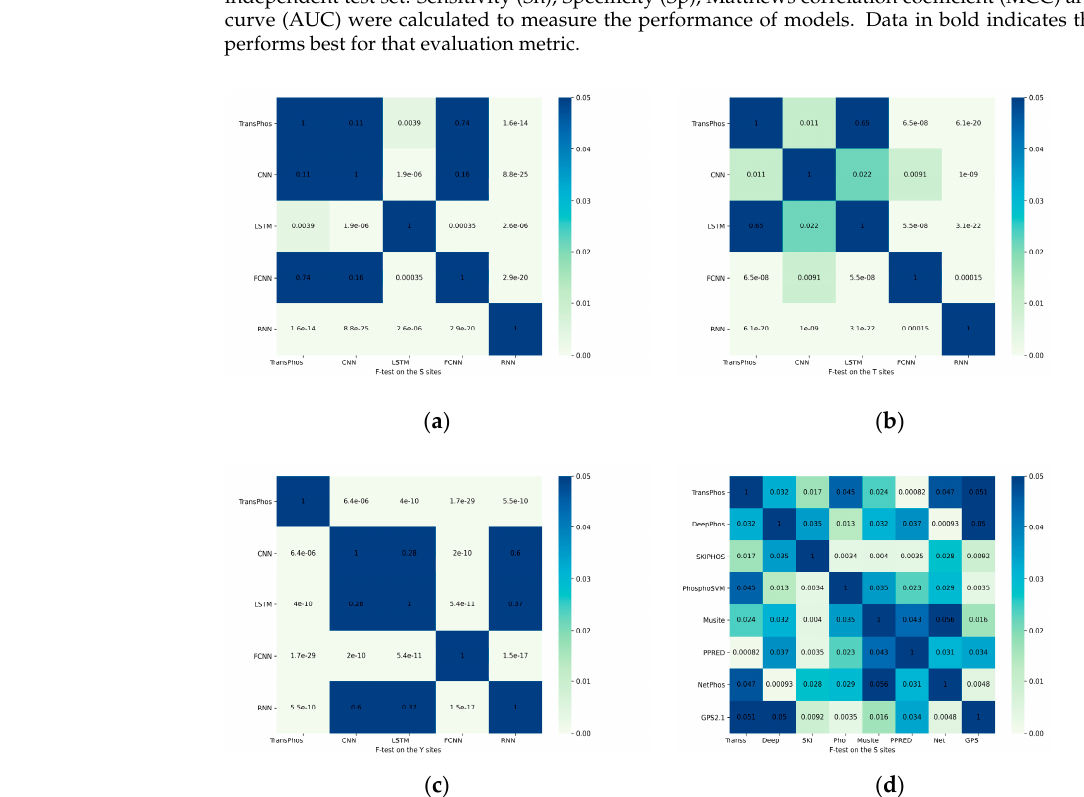
Figure 2. Heat map of the significance F-test, the value of each square in the graph is the p -value of the statistical test, and it is generally accepted that a p -value less than 0.05 means that the 2 statistics are significantly different. Here we use scientific notation, for example 1.6e-14 means 1.6 × 10 (cid:2879)(cid:2869)(cid:2872) . All statistical tests were performed on the predicted results of the test dataset PPA. In the horizontal coordinates, the names of some models are abbreviated to show them in full. ( a ) Significance F-test of the prediction results between the deep learning models for the S sites. ( b ) Significance F-test of the prediction results between the deep learning models for the T sites. ( c ) Significance F-test of the prediction results between the deep learning models for the Y sites. ( d ) Significance F-test of the prediction results for the S sites between other prediction models. ( e ) Significance F-test of the prediction results for the T sites between other prediction models. ( f ) Significance F-test of the prediction results for the Y sites between other prediction models. 3. Discussion In this work, we developed a deep learning model, named TransPhos, based on a transformer-encoder and CNN architecture, which can automatically learn features from protein sequences end to end to predict general phosphorylation sites. We performed 10- fold cross-validation on the training set and tested the model performance on an